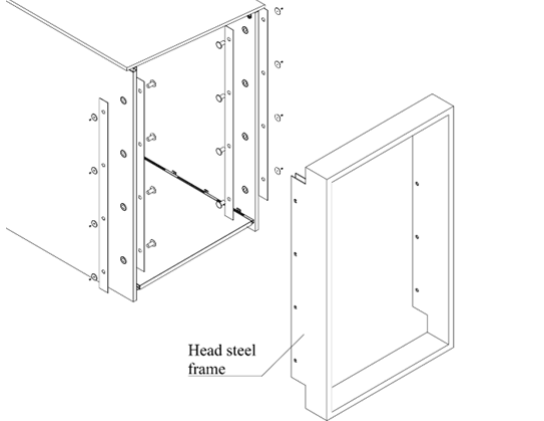
Fig. 6 Exploded view of the end of the